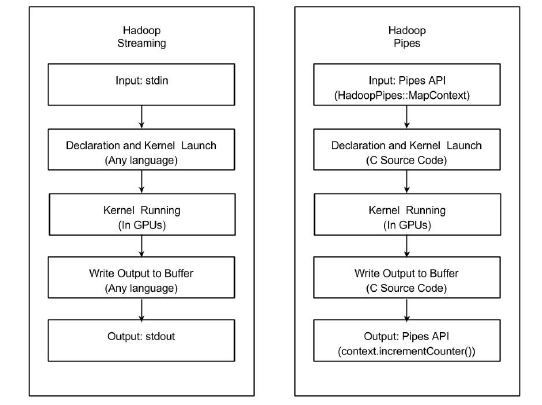
Fig. 8. Comparison of Hadoop Streaming and Pipes